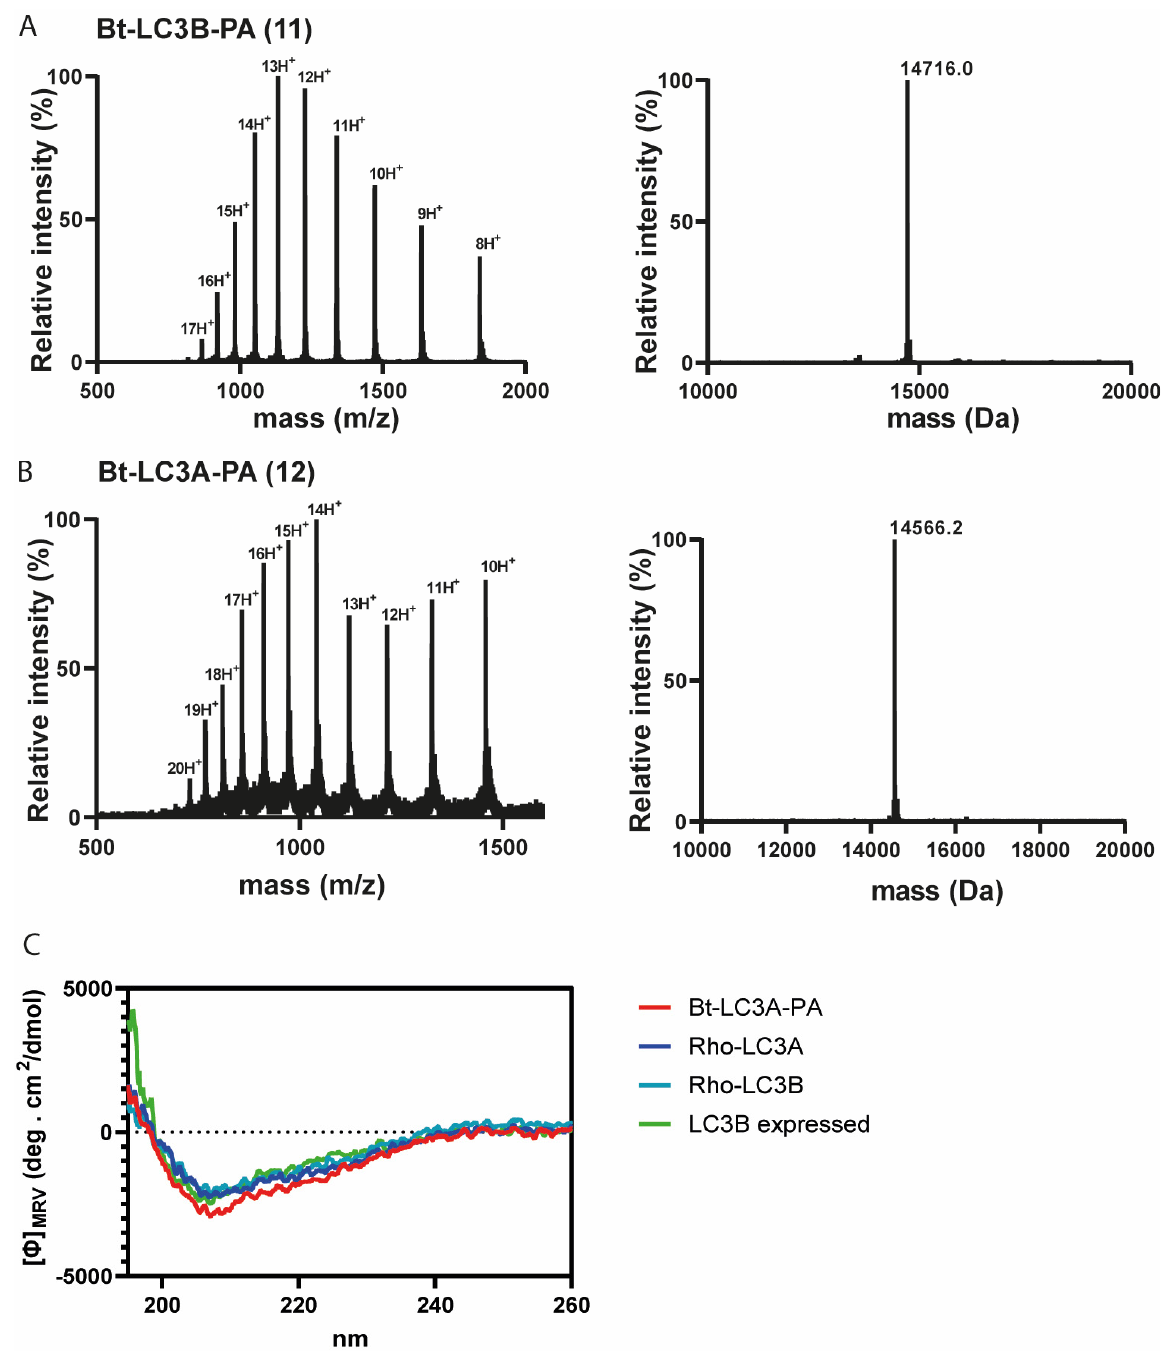
Figure 3. ( A ) Electro-spray ionization (ESI) spectrum of purified Bt-LC3B-propargylamide 11 (left panel) and deconvoluted mass (right panel). Calculated: 14,715.1 Da, observed: 14,716.0 Da, ( B ) ESI spectrum of purified Bt-LC3A-propargylamide 12 (left panel) and deconvoluted mass (right panel). Calculated: 14,565.6 Da, observed: 14,566.2 Da. ( C ) Circular dichroism spectra showing molar ellip- ticity Φ for recombinant LC3B, synthetic Rho-LC3A and Rho-LC3B and Bt-LC3A- propargylamide probe 11. Dashed line indicates no ellipticity. MRV: mean residue molar ellipticity value; deg: de- grees.